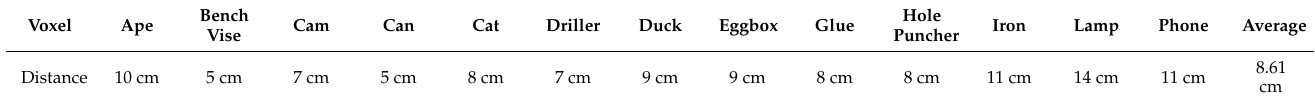
Table 3. Distance errors for the ground truth and estimated camera poses.